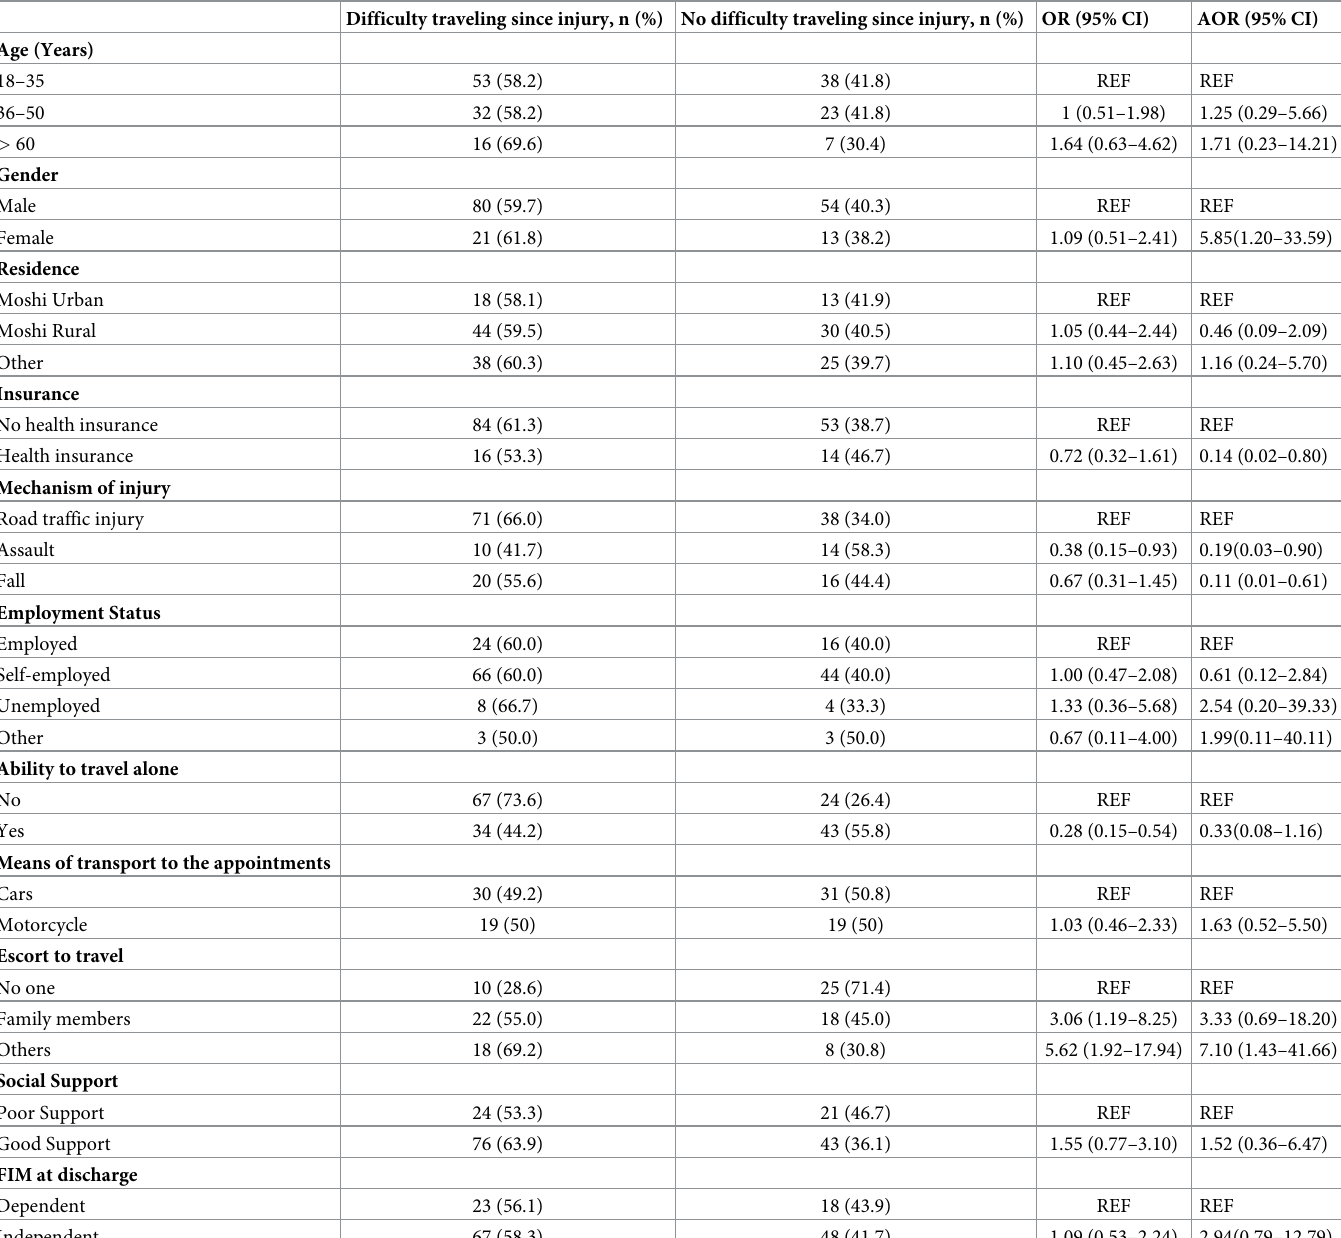
Table 2. Multiple regression model of patient demographics associated with difficulties in